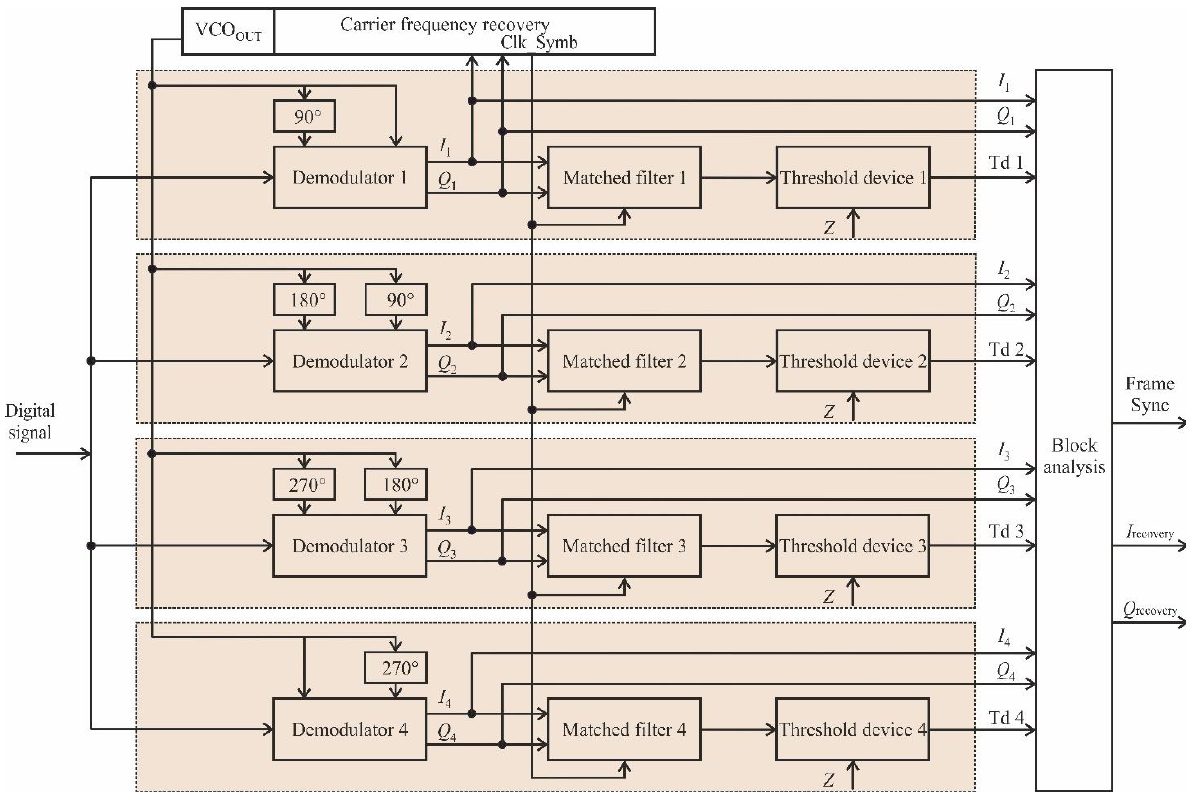
Fig. 5. Block diagram of a composite circuit of QPSK